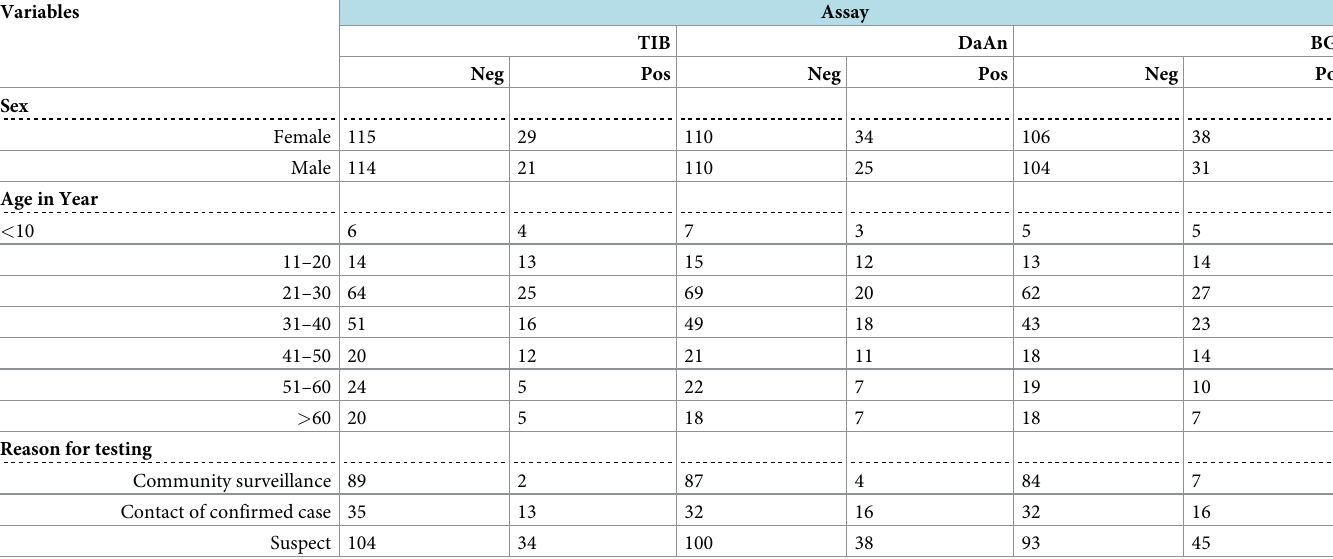
Table 3. Socio demographic characteristics of study participants against the three assays in Addis Ababa, Ethiopia, 2021(N = 279), 2021. Variables